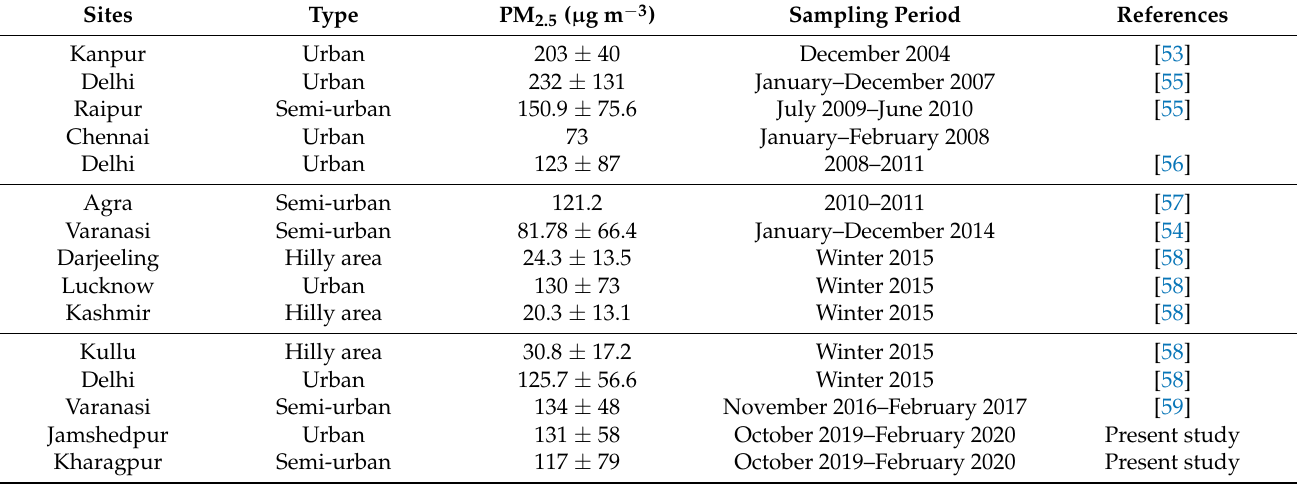
Table 1. Comparison of PM 2.5 mass concentration observed in this study with previous studies conducted in Indian